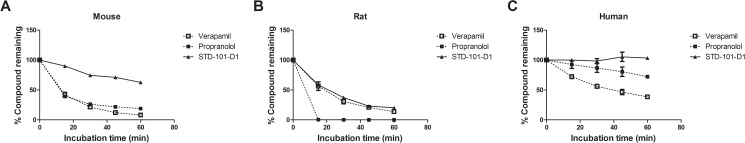
Metabolic stability in mouse, rat, and human microsomes.STD-101-D1 and two reference compounds verapamil and propranolol were incubated at 0.1 uM in mouse (A), rat (B), or human (C) liver microsomes. Serial samples were removed up until 60 min. All experiments were performed in duplicate, and data are represented as mean ± S.E.M.